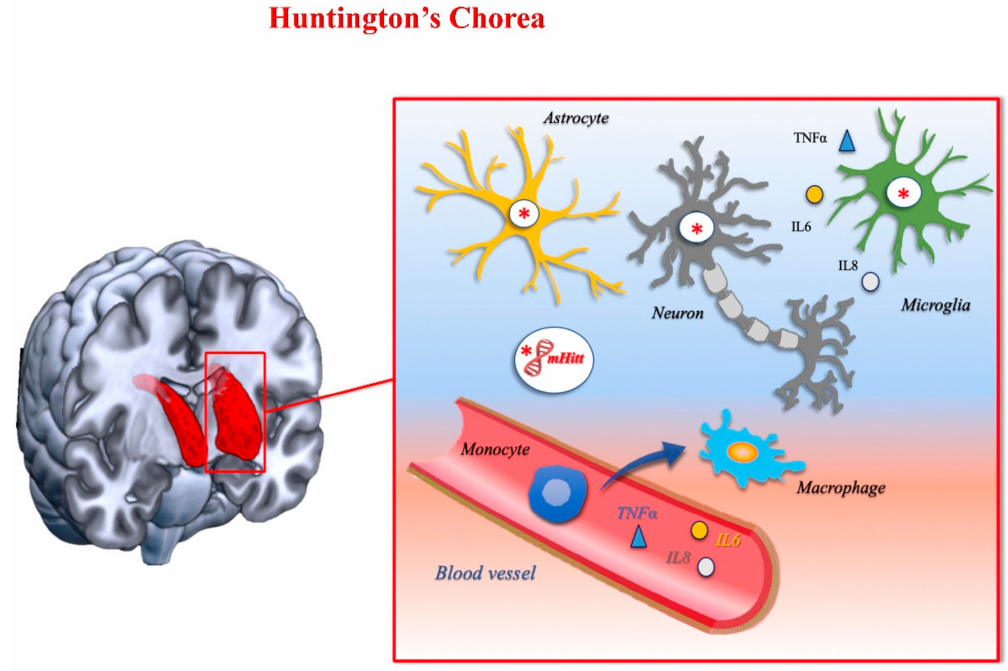
Figure 4. The immunological mechanisms associated with Huntington’s disease. *mHtt: mutated